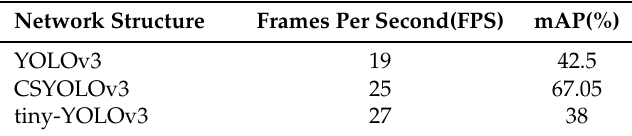
Table 1. Statistics of test results for different postures.